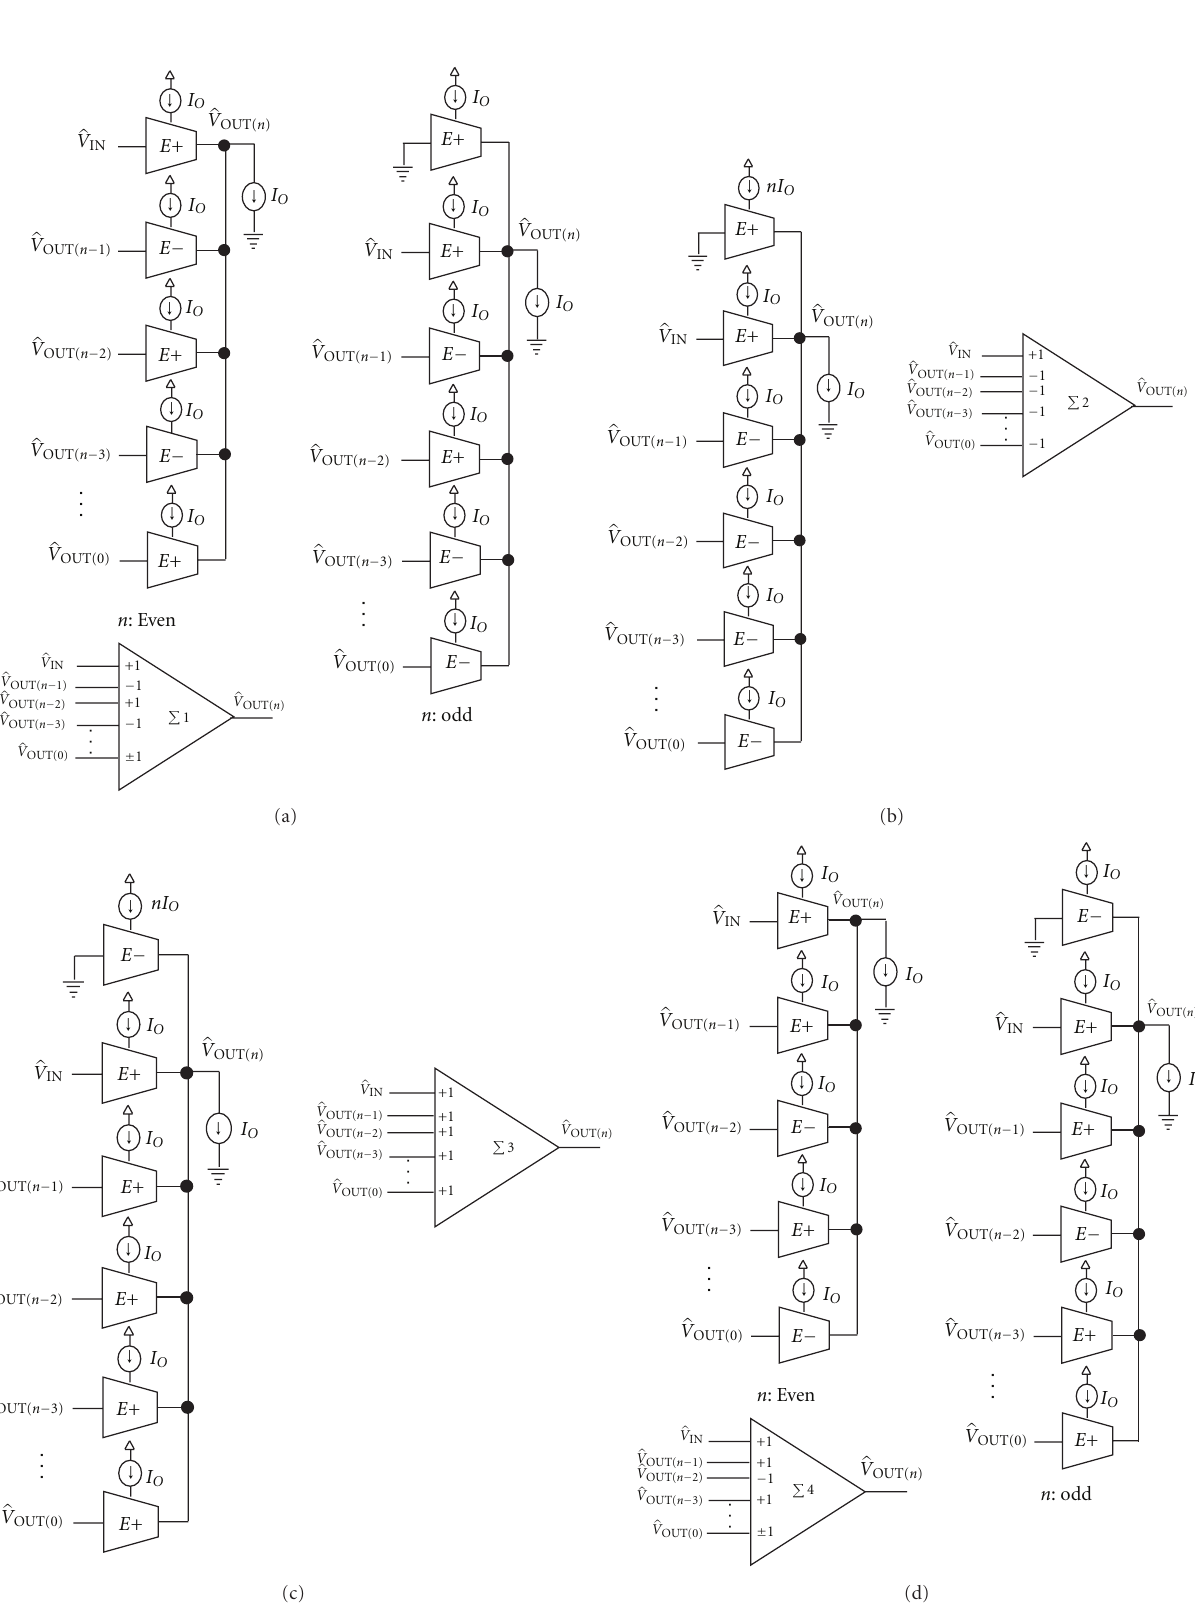
Figure 5: Multipleinput algebraic summation block (for even and odd order) and the employed symbol in all cases. (a) MFF1 (b) MFF2 (c) MFF3 (d)